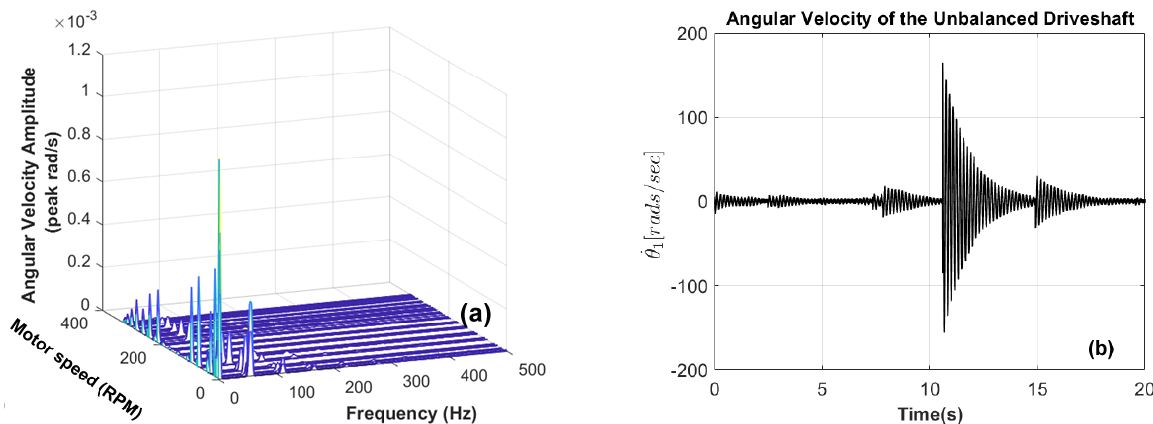
Figure 8. Driveshaft frequency domain of angular velocity during acceleration. ( a ) motor speed variation frequency ( b ) angular velocity vibration amplitude of the unbalanced driveshaft.